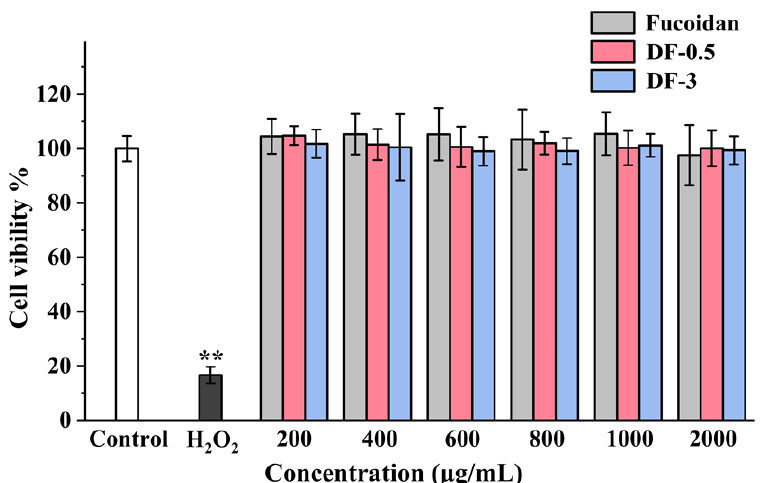
9 of 13 Figure 4. The chemical structure change of fucose during photocatalytic degradation reaction. 3.4. Cytotoxicity of the Degraded Fucoidans Considering the emergence of novel fragments in the photocatalytic degradation, it is necessary to evaluate the toxicity of the degradation products of fucoidan for the safety in their further application. Numerous researches have revealed that fucoidan could re- duce the HT-29 cell proliferation or induce apoptosis of HT-29 cells [35,36]. Then, in the present study, the influences of fucoidan, DF-0.5 and DF-3 on the proliferation of HT-29 human colon adenocarcinoma cells were determined by the MTT method. As shown in Figure 5, all the three samples showed no significant cytotoxicity at concentrations ≤ 2000